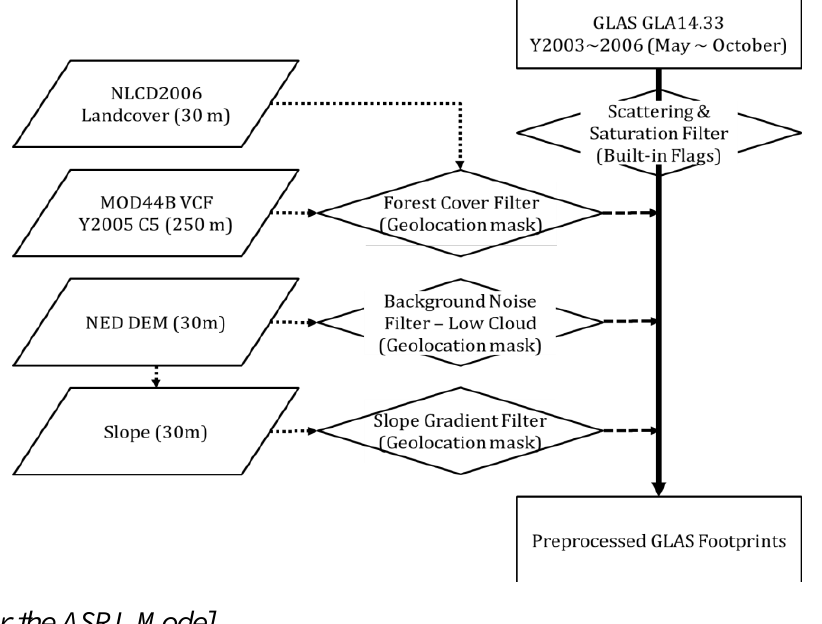
Figure 1. Preprocessing/filtering steps for determining valid GLAS waveform